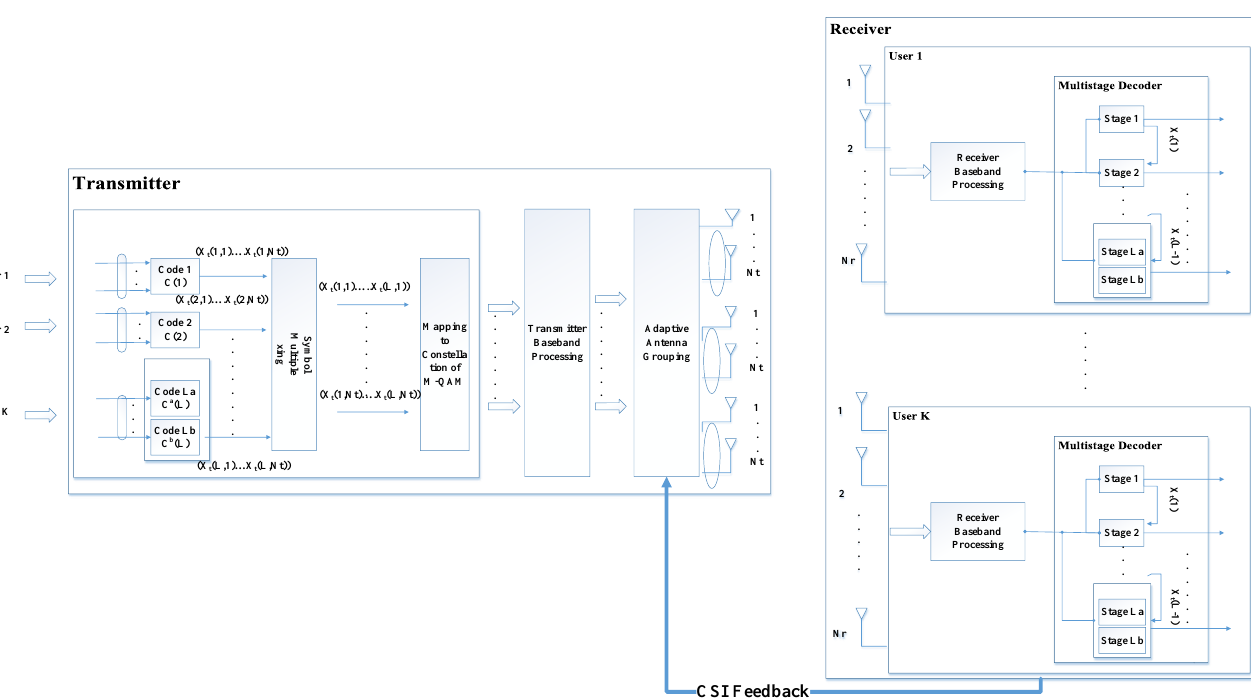
Figure 2. Proposed AAG in Multi-User Massive MIMO systems.